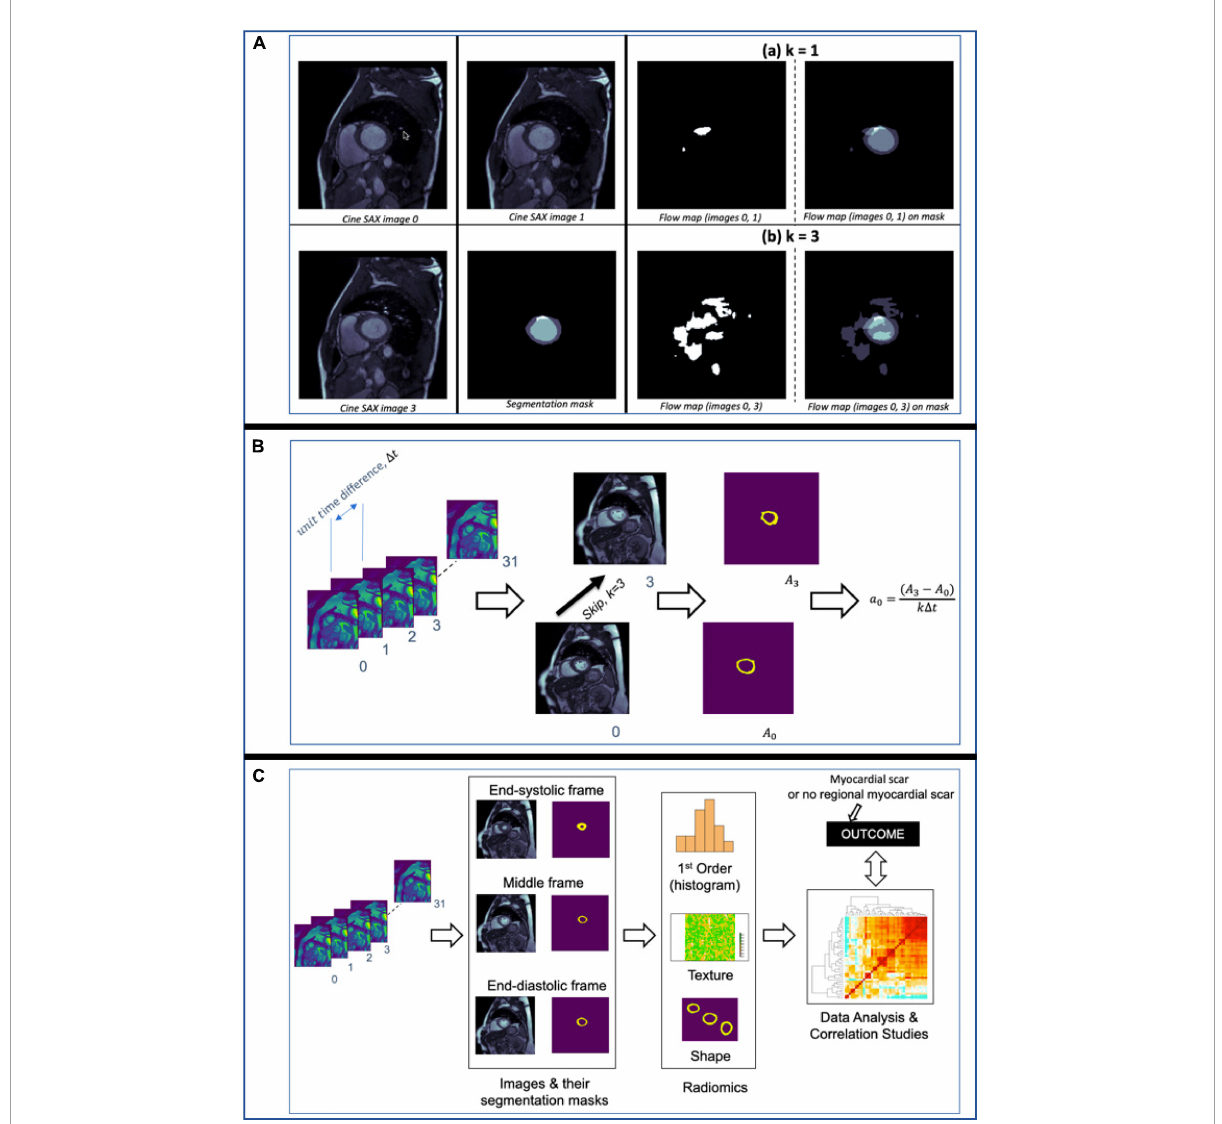
FIGURE5 (A) Flow maps showing the pixels that have been displaced between the time the two cine SAX image frames were acquired with the skip intervals k = 1 in (a) and k = 3 in (b). On the left in (a), flow map (images 0, 1) represents the pixel-wise displacement between image 0 and image 1, and the corresponding the pixel-wise displacement between image 0 and image 3 is shown at the bottom. The images on the left show the super-imposition of the flow map images on the segmentation masks. (B) An illustration of the computation of rate of change of myocardial cross-section area for a given slice location. The rate of change of myocardial area between frames captures the pixel-wise area change information of slices through the cardiac cycle. (C) An illustration of the computation of radiomics features of three frames namely, the end-diastolic (ED) frame, end-systolic (ES) frame and the “middle” frame in between the ED and ES frames. The shape, first-order, and texture radiomics features are extracted and then a statistical test (Pearson correlation analysis) to assess the significance of these features in relation to the binary outcome (i.e., with or without MI).